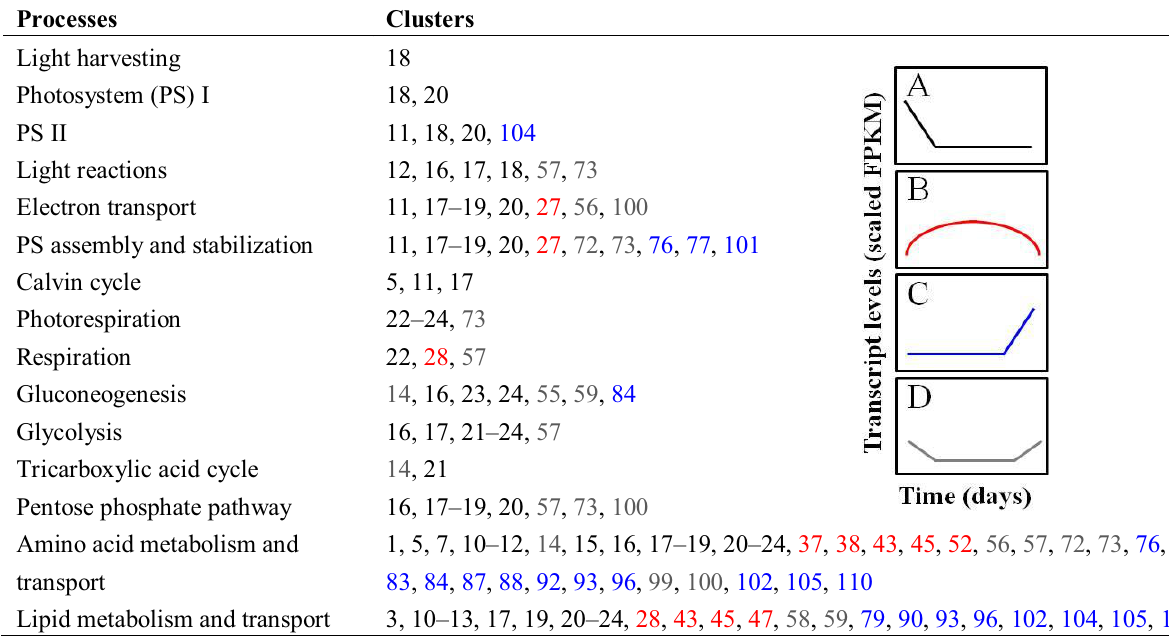
Figure 3. Major metabolic processes of CCNM and relevant clusters enriched in transcripts encoding a variety of proteins involved in these processes. GO enrichment analysis was performed on isoforms in all 114 clusters ( p -value < 0.05). Only clusters displaying four basic trends consistent with: ( A ) early (initial decrease followed by stable low or no expression; black); ( B ) seed filling (moderate increase followed by a moderate decrease; red); ( C ) maturation (stable low or no initial expression followed by a final increase; blue); and ( D ) early and maturation (initial decrease followed by no or low stable expression and final increase in transcript levels; gray) CCNM are shown. Clusters showing conceptually similar trends based on visual assessment have the same color that matches the corresponding